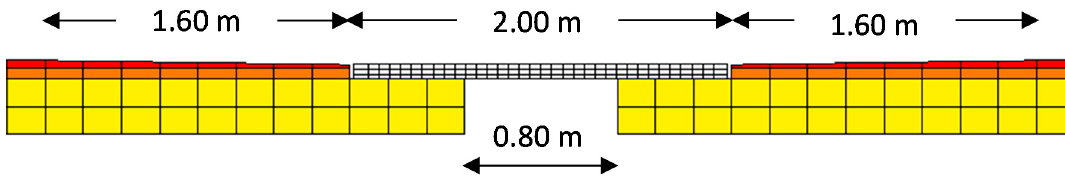
Figure 7. Pavement and BEJ model (detail of the BEJ zone).